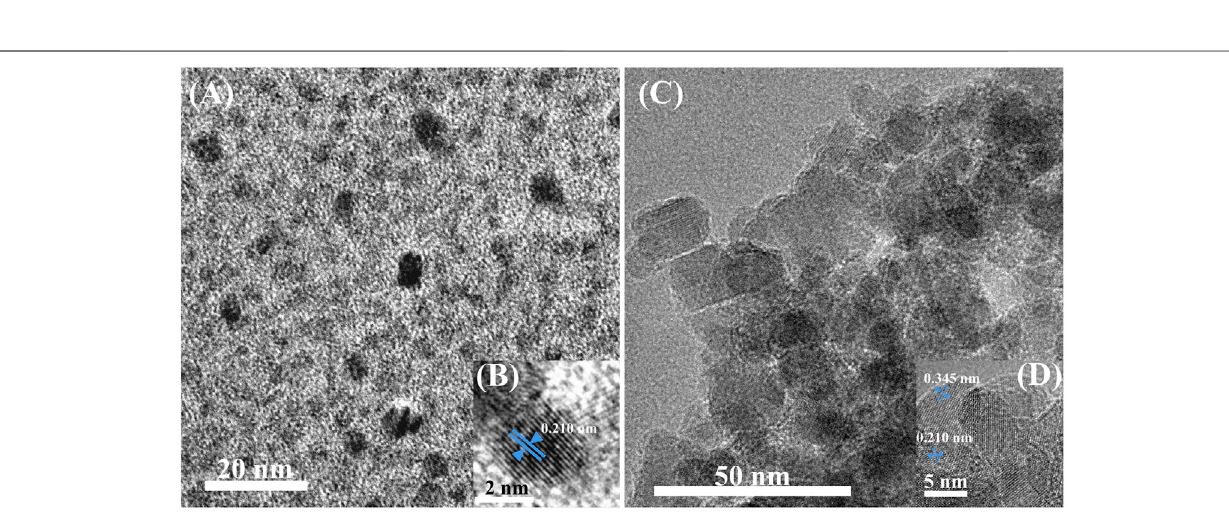
Frontiers in Chemistry |